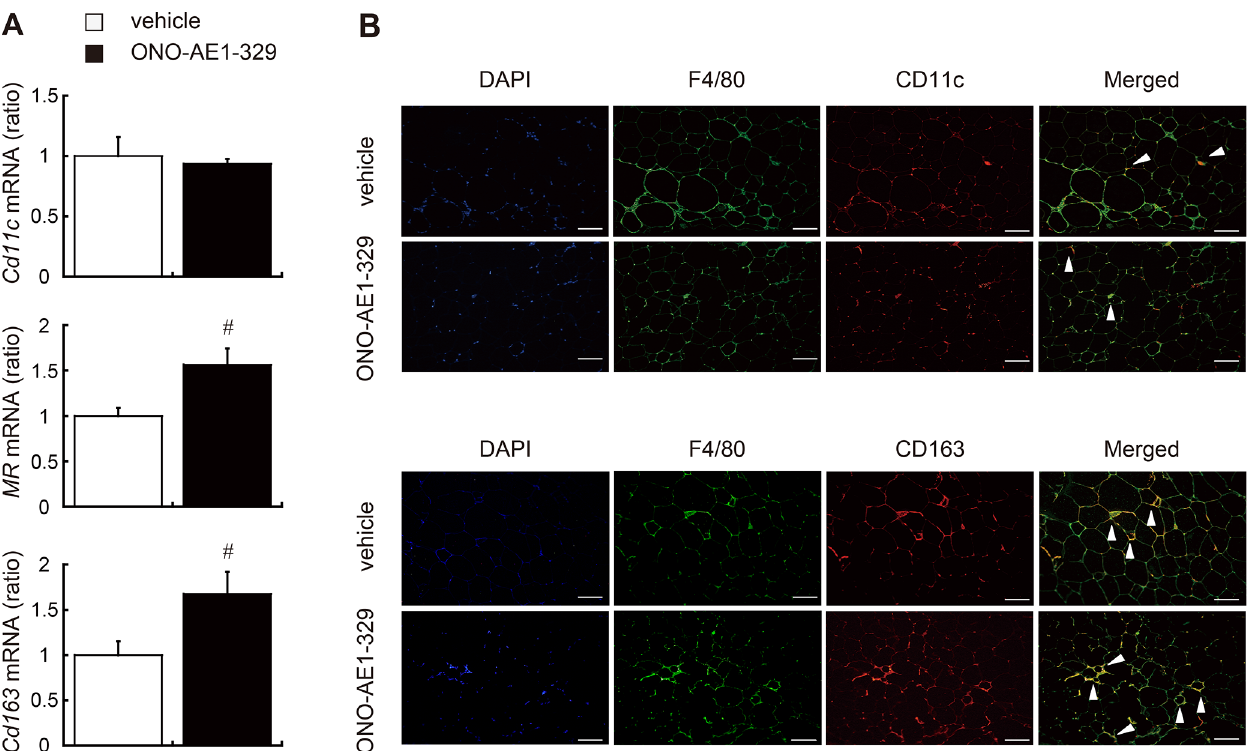
Fig 4. Administration of EP4 agonist alters adipose tissue macrophage polarization. (A) Relative expression of marker genes for M1 ( Cd11c ) and M2 ( MR , Cd163 ) macrophages in epididymal fat tissues from db/db mice administered EP4 agonist (black bar) or vehicle (white bar). All values are mean ± SEM (n = 4 – 5 each). ] p < 0.01 vs. vehicle. (B) Epididymal adipose tissues of EP4 agonist – or vehicle – treated db/db mice were double stained with anti-F4/80 (green), and anti-CD11c (red, upper panel) or anti-CD163 (red, lower panel) antibodies. Arrows indicate double-positive cells. Scale bar: 100 μ m. MR, Mannose Receptor.